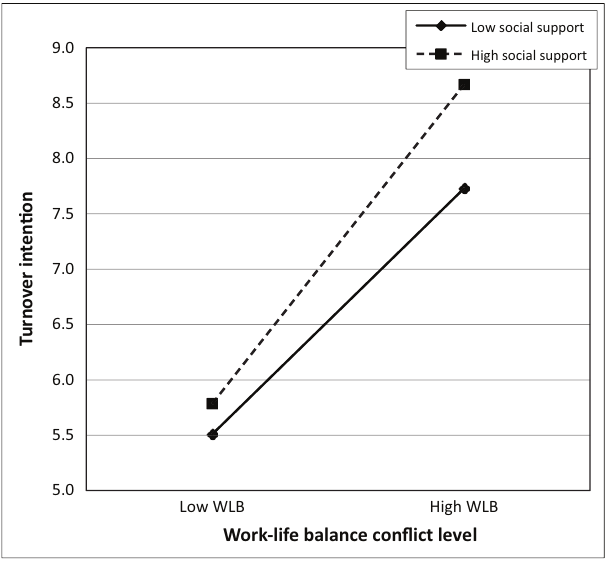
FIGURE 2: Gender as a moderator on the work-life balance–turnover intention relationship (two-way interaction).